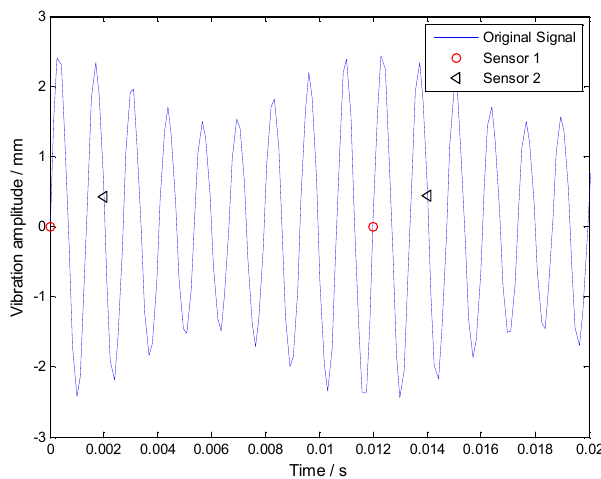
Figure 11. Non-uniformly sampled signals of two BTT sensors in the time domain.